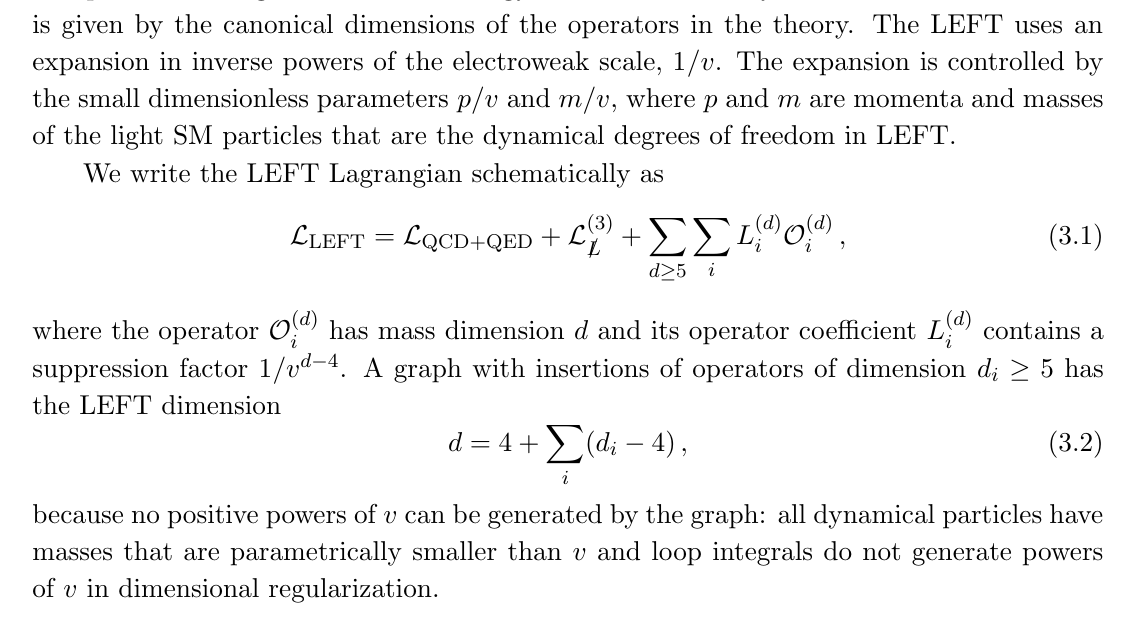
h : c : , appearing in table 1. For n operators. The dimension-six operator sectors that violate baryon and/or lepton number consist of operators with (cid:1) L = (cid:6) 4, (cid:1) L = (cid:6) 2, (cid:1) B = (cid:1) L = (cid:6) 1, and (cid:1) B = (cid:0) (cid:1) L = (cid:6) 1 appearing in table 2 of appendix A. For n are six (cid:1) L = 4 operators, 600 (cid:1) L = 2 operators, 288 (cid:1) B = (cid:1) L = 1 operators,